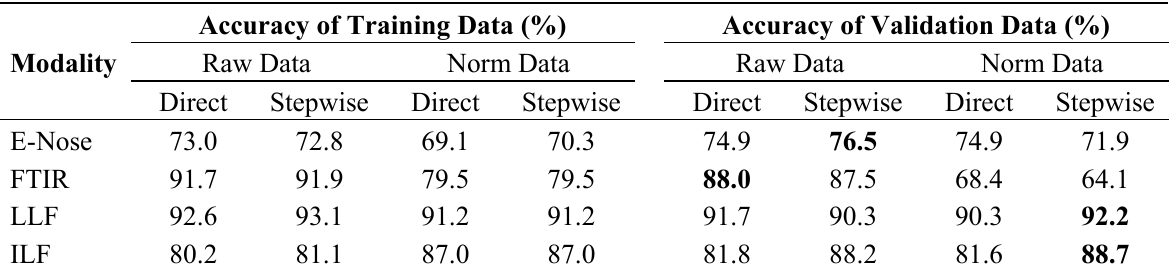
Table 4. Summary of LDA classification